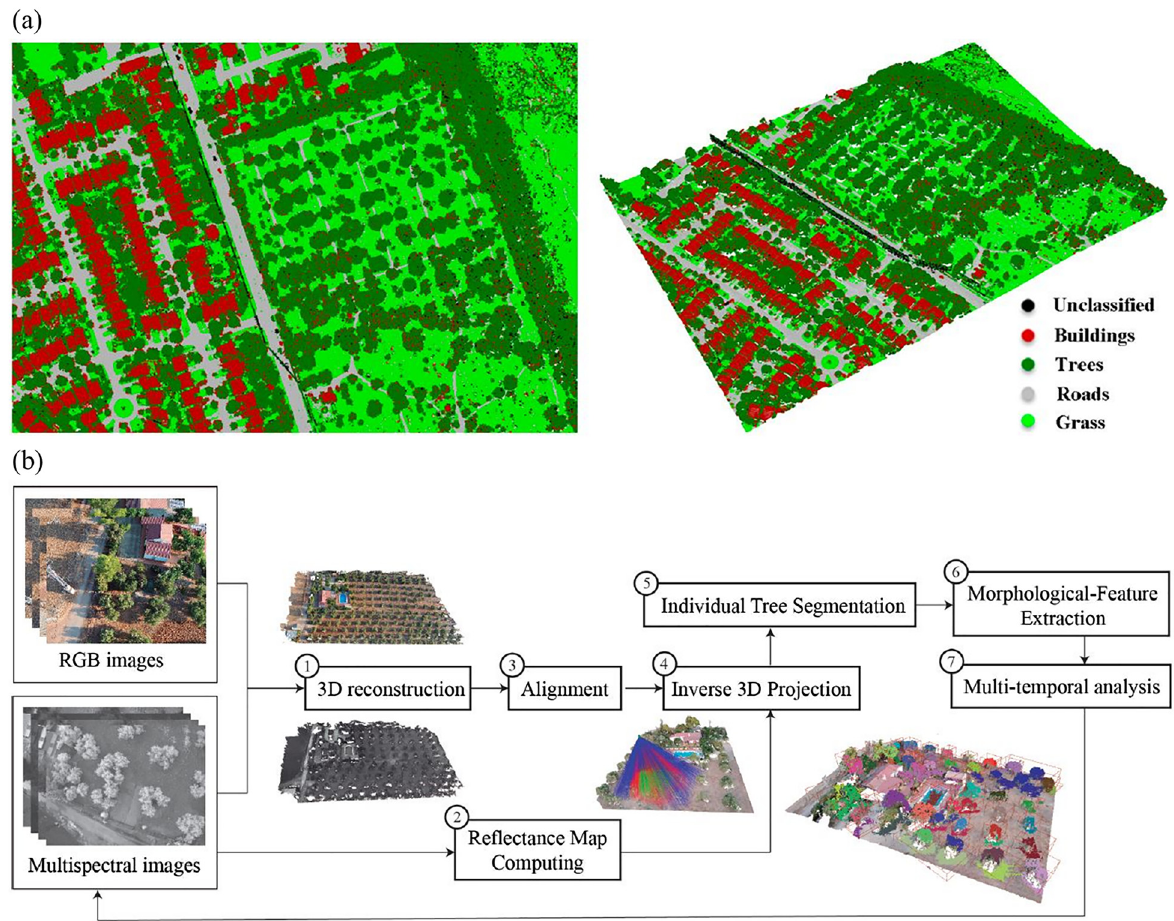
Figure 2: Airborne multispectral environment sensing and monitoring. (a) 2D and 3D multispectral images for urban area classification. These images are based on normalized difference vegetation indices (NDVI) computationusing the recorded intensity at 532 and 1064 nm wavelength. (b) RGB and multispectral images of olive orchard and the imaging process fl ow for olive tree analysis. (a) and (b) are adapted with permission from the studies by Morsy et al. [11] and Jurado et al. [35], respectively. Both are licensed under a Creative Commons